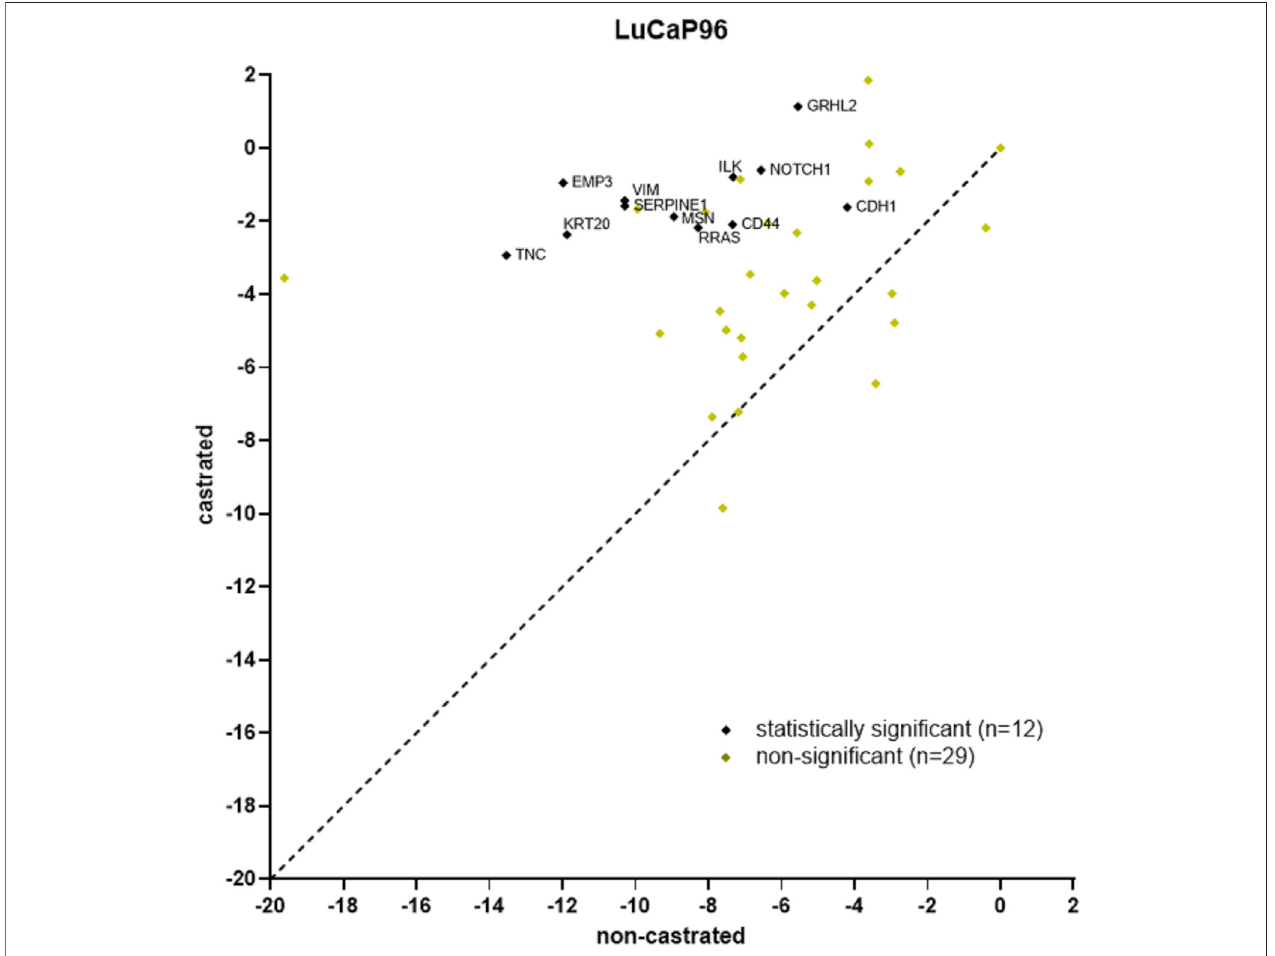
FIGURE7| ScatterplotofLuCaP96modelCTCgeneexpressionRT-qPCRresultsforcastratedversusnon-castrated(datafrom(Hassanetal.,2021b))mice.12/ 41 genes had signi fi cantly different expression ( p < 0.05). RPL32 normalised Δ Ct values are plotted and each point denotes an individual gene. Signi fi cant differences in gene expression values between CTCs from castrated and non-castrated mice were identi fi ed using the Benjamini, Krieger and Yekutieli two-stage linear step-up procedure to control the false discovery rate (Q = 5%, p < 0.05).